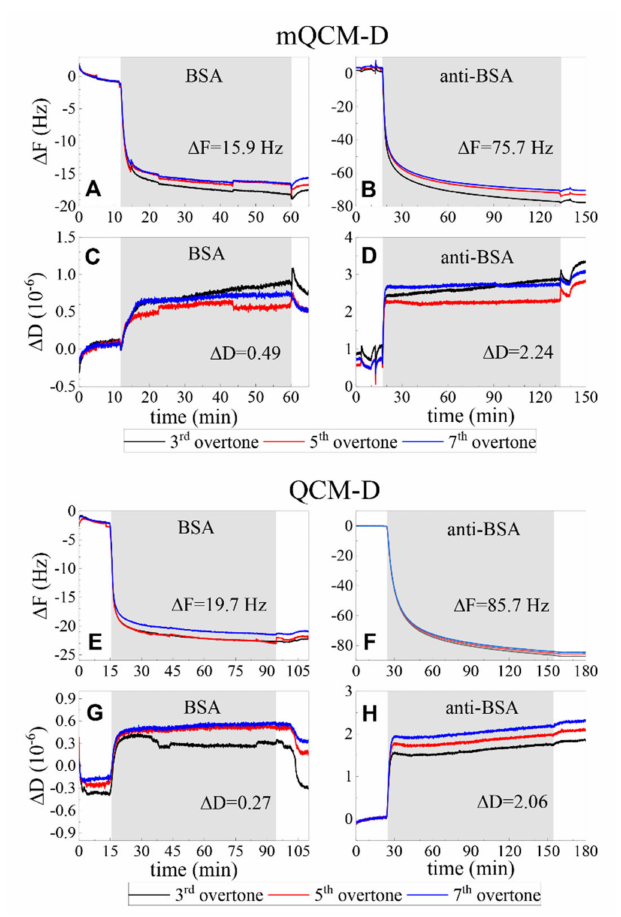
Figure 7. The BSA immobilization and anti-BSA affinity kinetics of modified mQCM-D ( A – D ) and QCM-D ( E – H ) sensor chips for changes in resonance frequency shift ∆ F ( A , B , E , F ) and energy dissipation ∆ D ( C , D , G , H